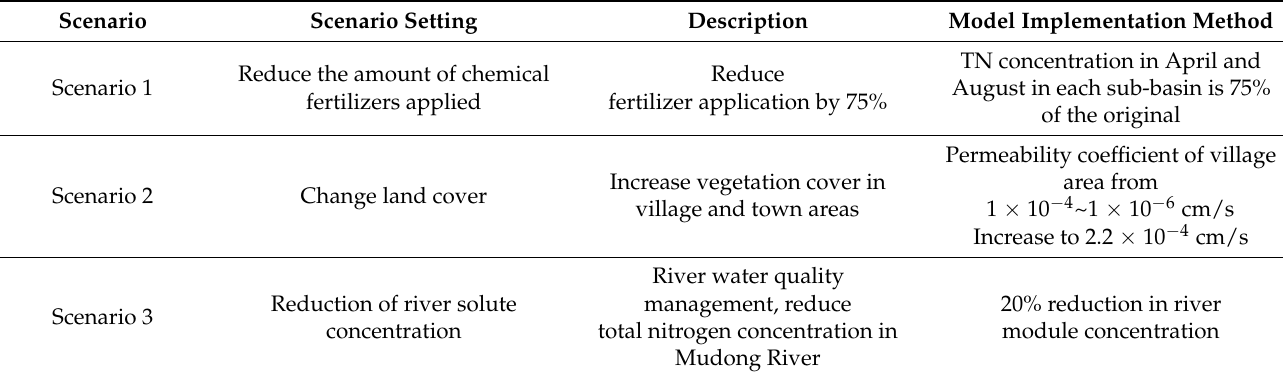
Table 3. Scenario setting of non-point source pollution control